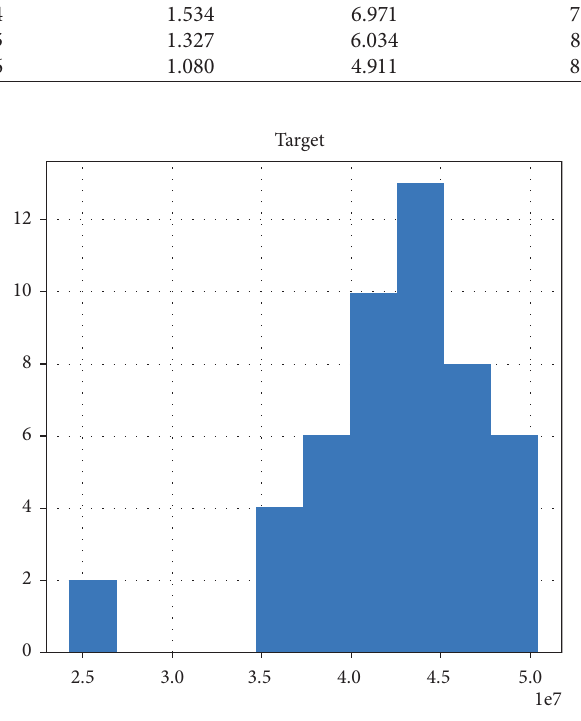
Figure 4: Histogram of the normal test.